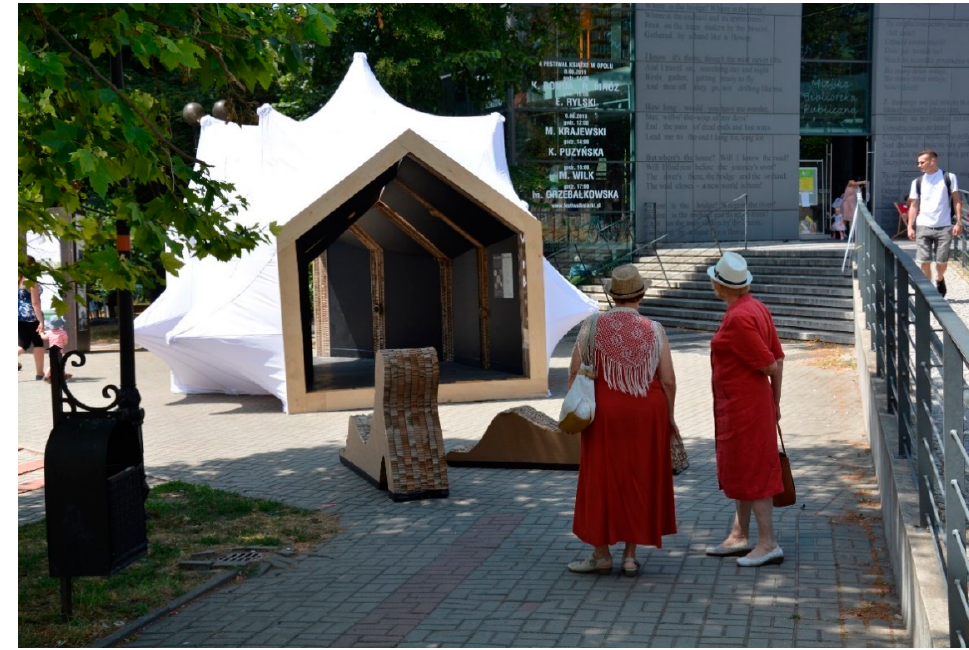
Figure 19. Obverse/Reverse Pavilion in the public space of Plac Wolno ś ci.